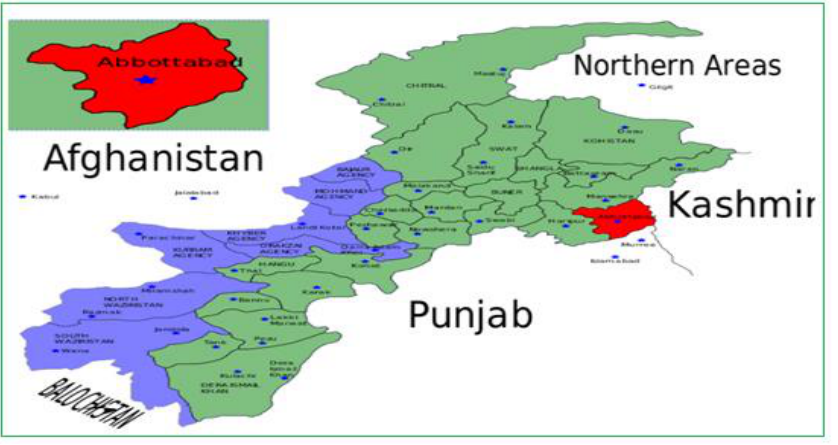
Figure 1. The study area (Abbottabad) shown on the map of